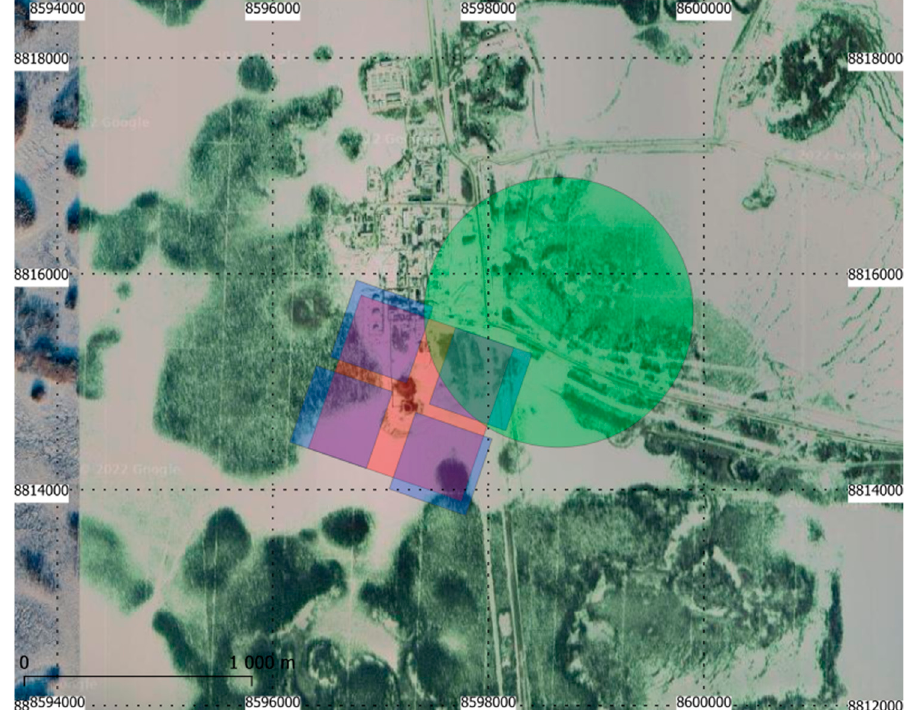
Figure 12. Footprints of the “ mutual” detections of the same gas flare in Khanty-Mansiysk at 61.809N 77.237E in EPSG:900913 projection observed with three satellites on 23 August 2015. Daytime background comes from satellite view in Google Maps.